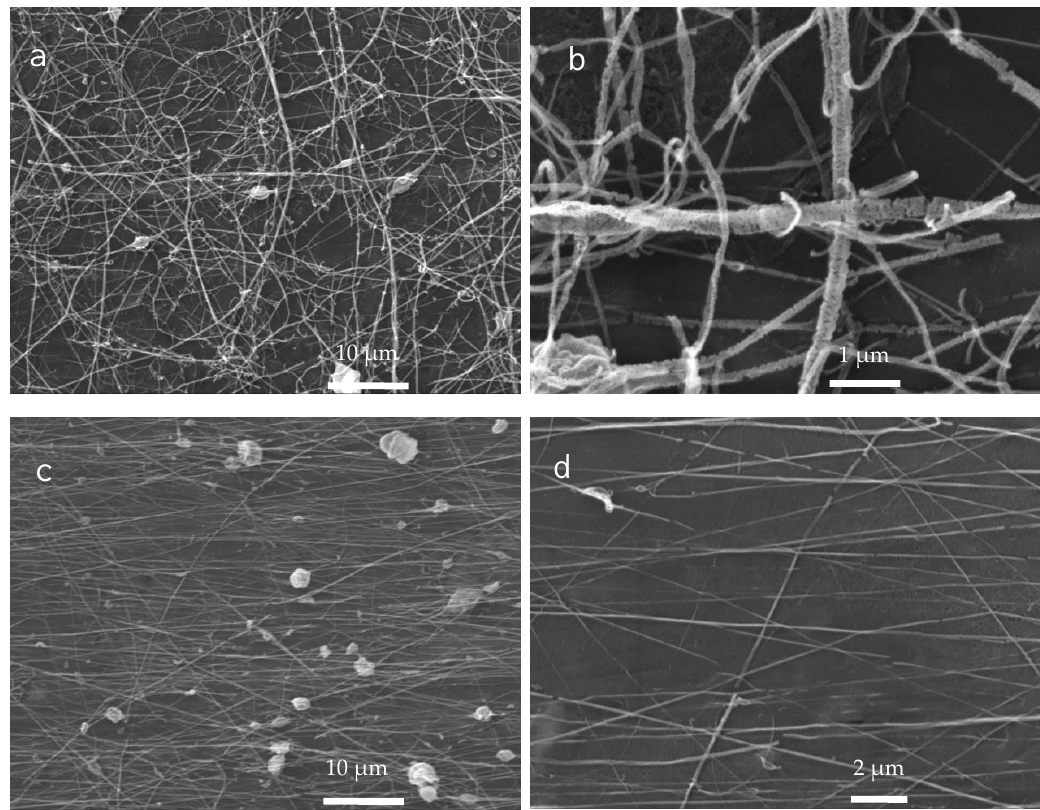
Figure 9. SEM images of chitosan fibers. ( a , b ) R-chitosan fibers and ( c , d ) A-chitosan fibers.